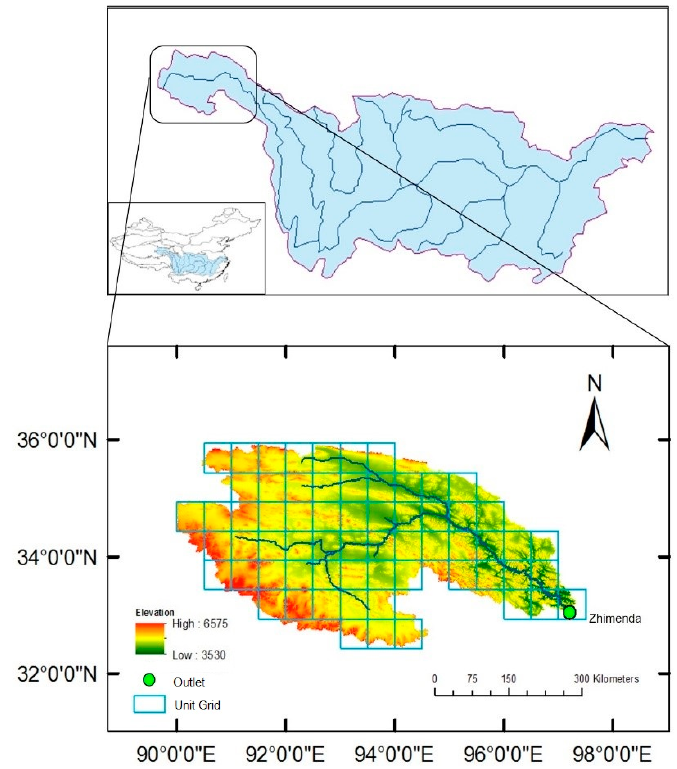
Figure 1. Location of the source region of the Yangtze River (SRYR) and grid net used for simulations.